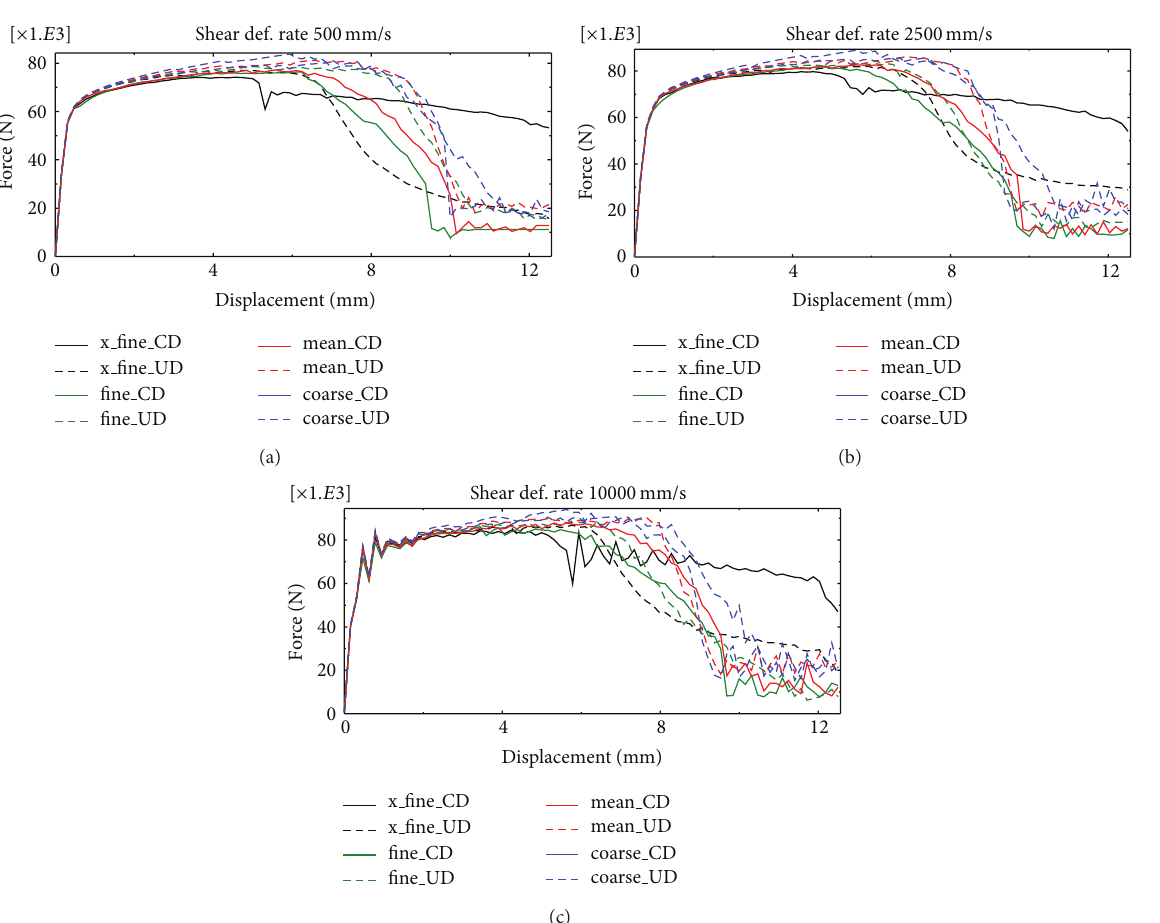
Figure 4: Force [N]-displacement [mm] curves from shear test analyses with displacement rates: (a) 500 mm/s, (b) 2500 mm/s, and (c) 10000